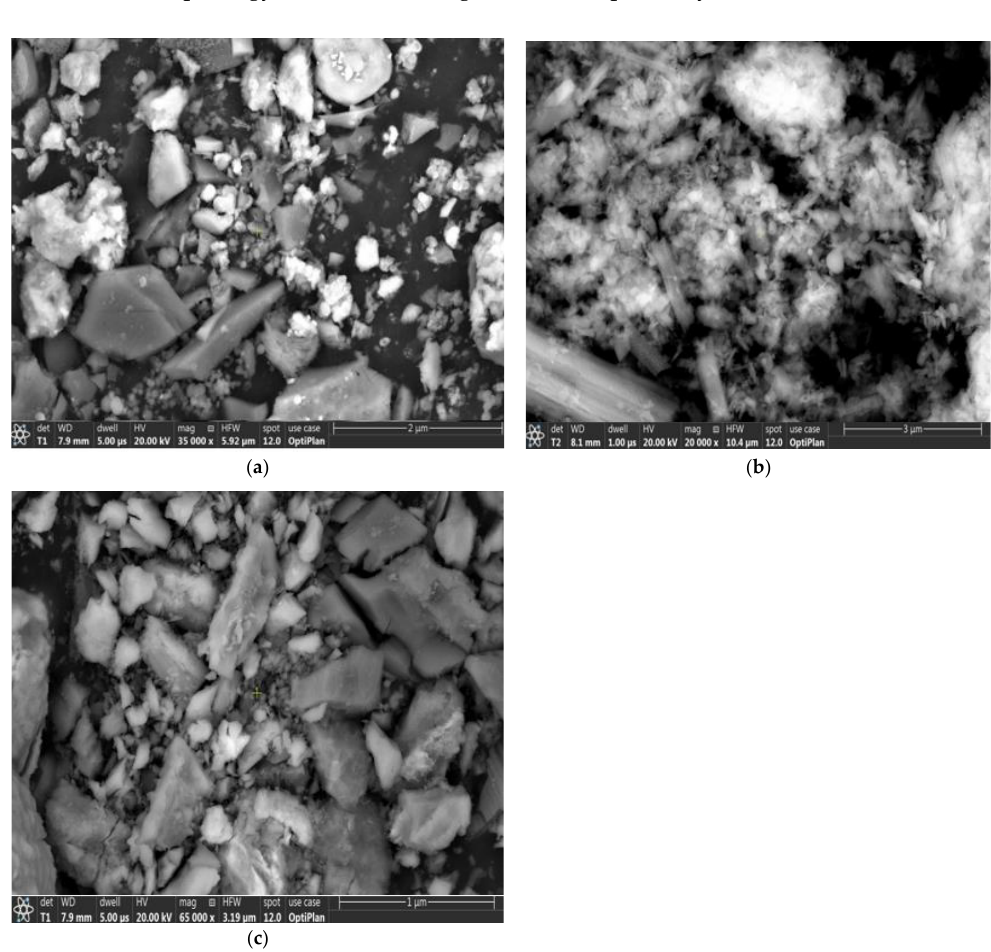
Figure 9. SEM images of ( a ) Co(II), ( b ) Cu(II), and ( c ) Zn(II)